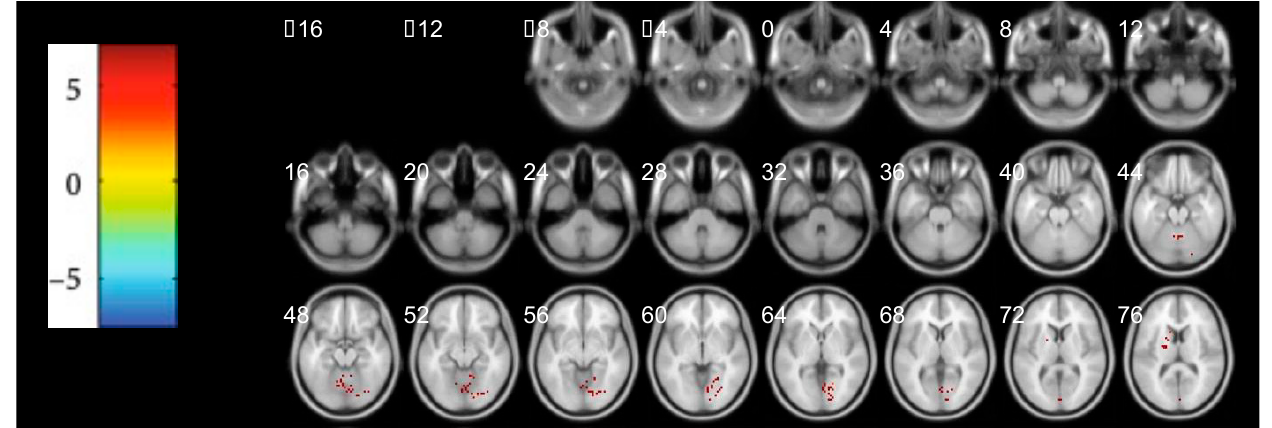
Figure 2. Significant alterations in mfALFF between the PT and HC groups ( p < 0.05, FDR Correction, p < 0.05) in the transverse position. Regions of red colors represented these areas had increased high values of mfALFF. Likewise, the darker the red color, the higher intensities of mfALFF. mfALFF: mean fractional amplitude of low-frequency fluctuation, FDR: False Discovery Rates, PT: patient group, HC: healthy control.